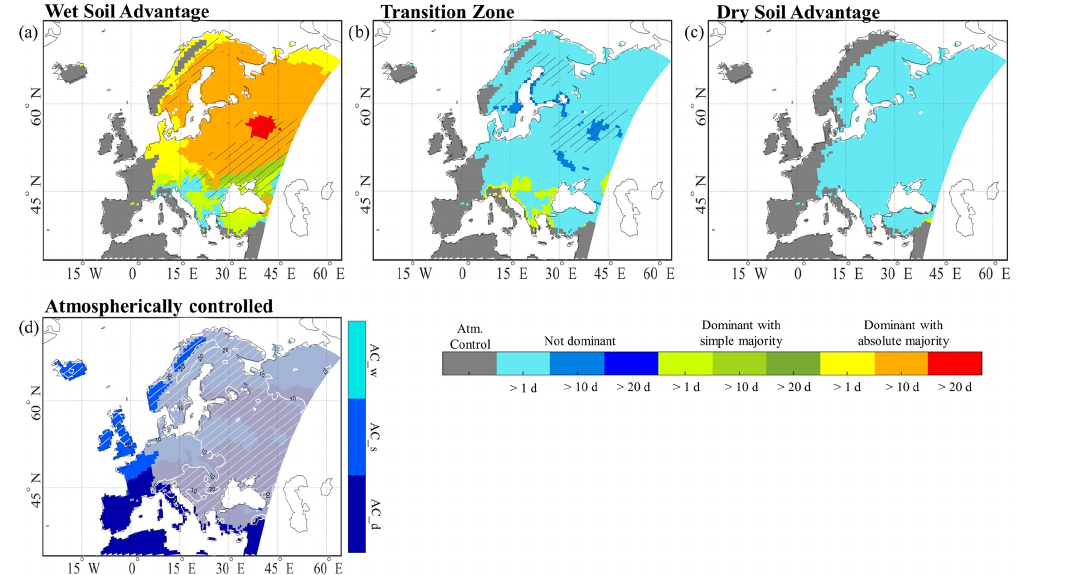
Figure 15. Uncertainty maps of the non-atmospherically controlled classes: (a) wet soil advantage, (b) transition zone and (c) dry soil advantage. The colors indicate whether a class is on average dominant in absolute or simple majority, or whether another class is dominant. The color gradation denotes the average number of days. The hatching indicates that in these regions the variance in the number of days in this class is larger than 10%. Panel (d) shows which atmospherically controlled class dominated in all cases. The hatched area marks the region in which the spread between the modification cases in occurrence of atmospherically controlled days per season is larger than